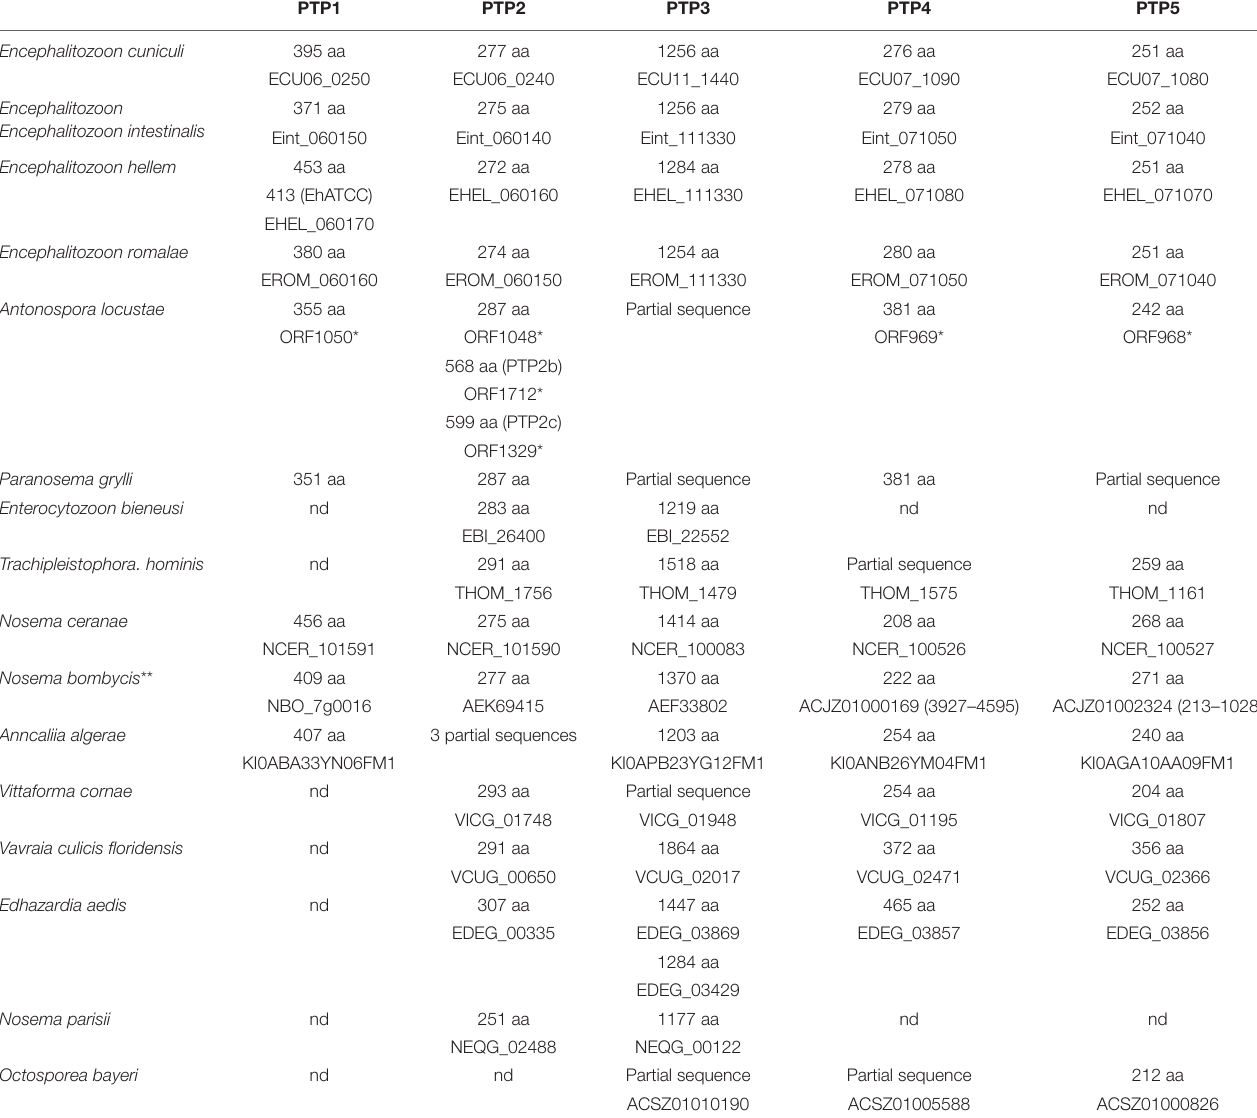
TABLE 3 | Polar tube proteins PTP1 to PTP5 in